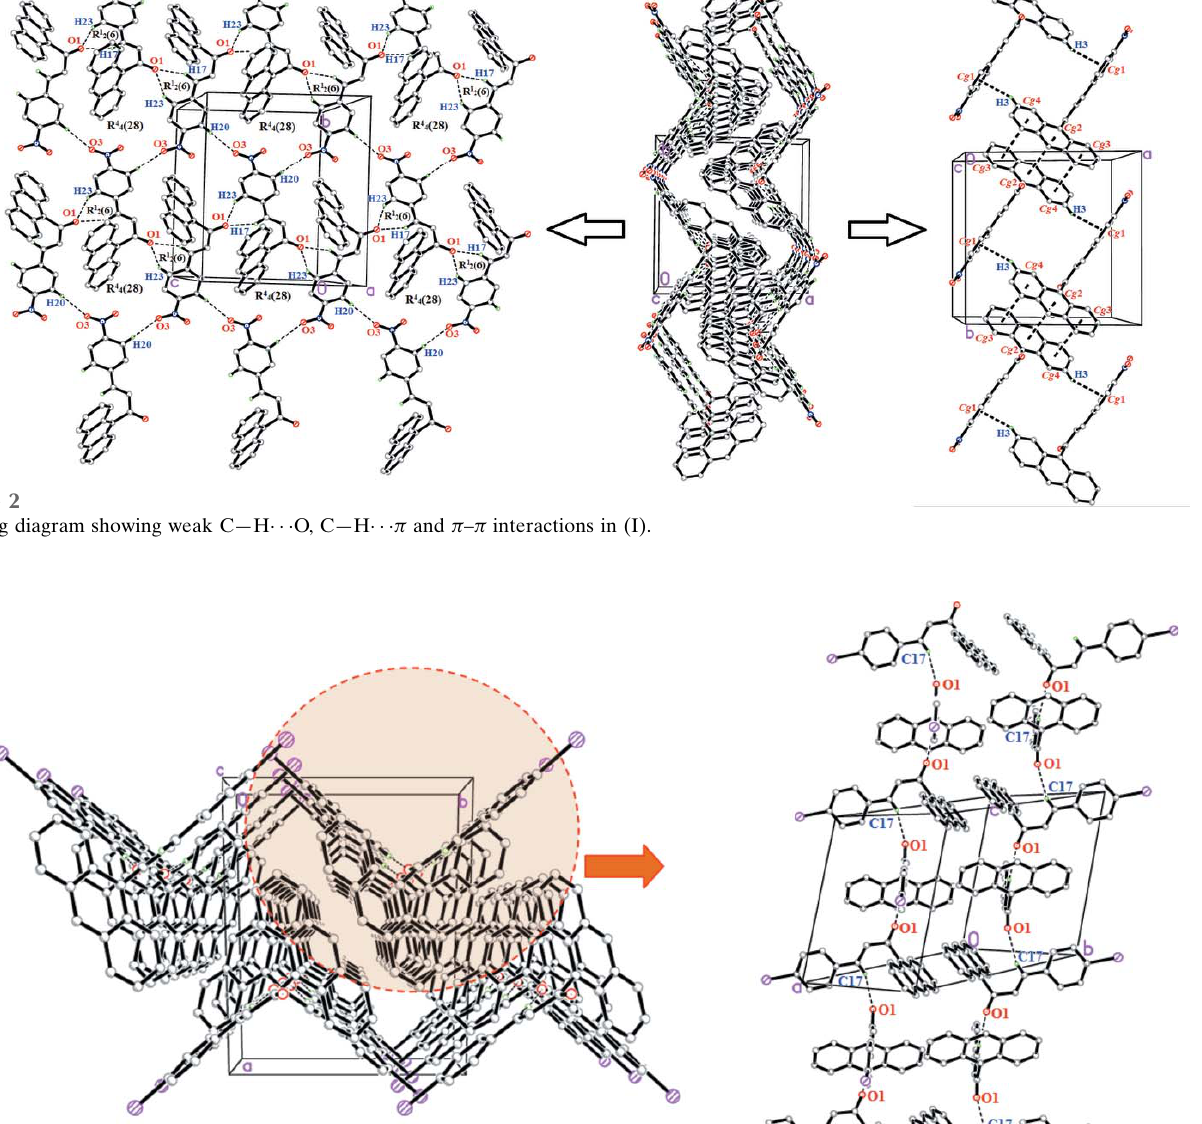
Table 1). C—H (cid:4) (cid:4) (cid:4) (cid:2) and (cid:2) – (cid:2) interactions [ Cg 2 (cid:4) (cid:4) (cid:4) Cg 2(1 (cid:2) x , (cid:2) y , 1 (cid:2) z ) = 3.6900 (9) A˚ and Cg 3 (cid:4) (cid:4) (cid:4) Cg 4(1 (cid:2) x , (cid:2) y , 1 (cid:2) z ) =